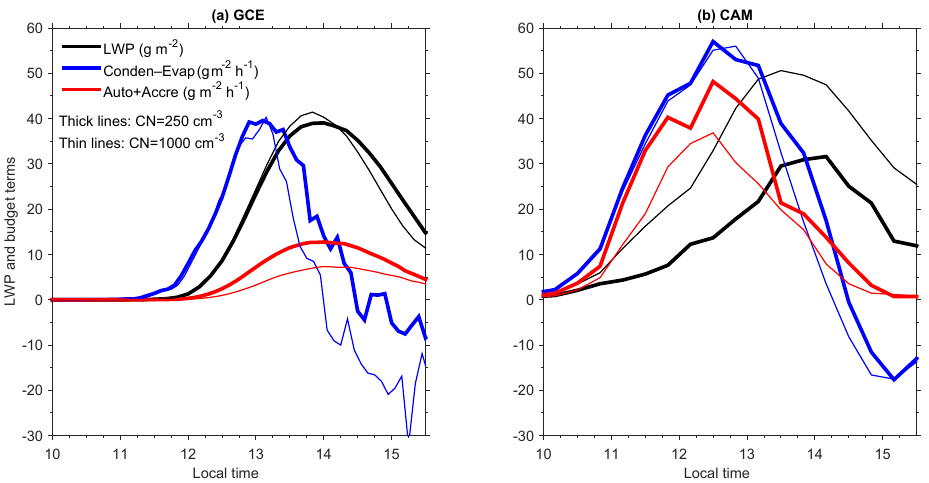
Figure 3. LWP and the column-integrated LWP source and sink terms from the cases with surface aerosol number concentration equal to 250cm − 3 (thick lines) and 1000cm − 3 (thin lines) for (a) GCE and (b)